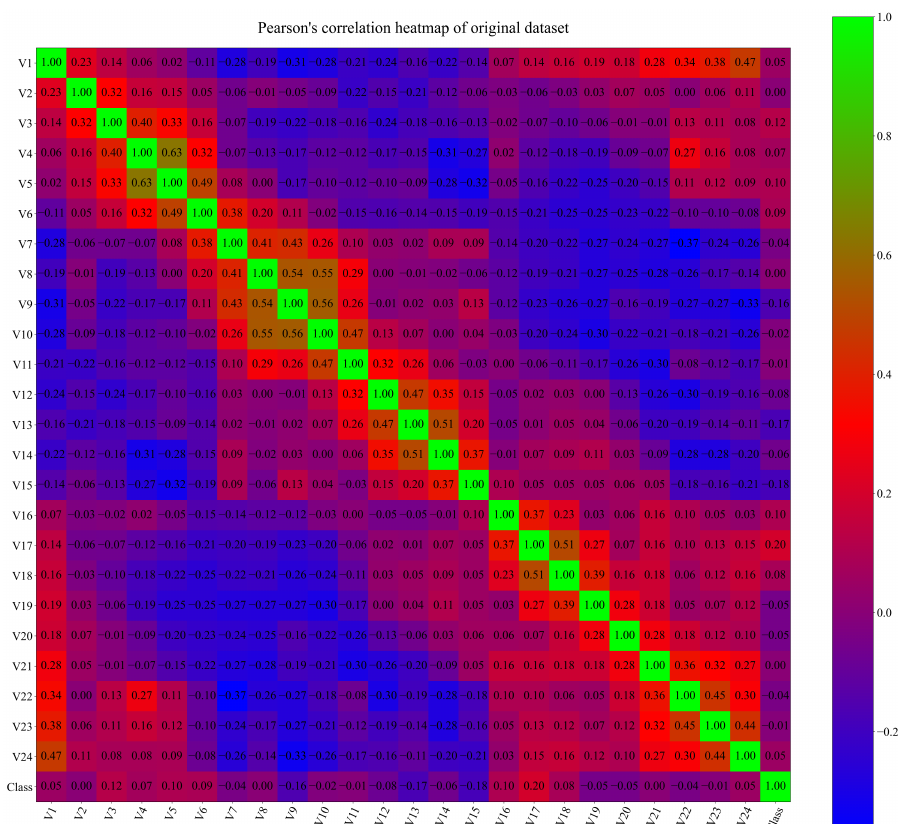
Figure 2. The Pearson’s correlation analysis of the dataset variables.